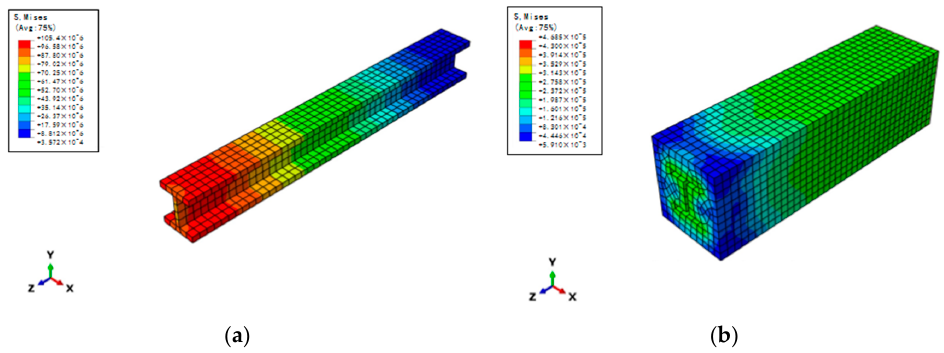
Figure 14. Mises stress nephogram of SRRC-1: ( a ) section steel; ( b ) RAC.